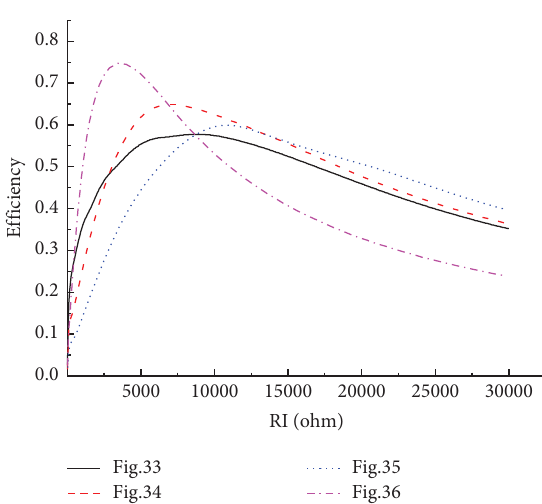
Fig.33 Fig.34 Figure 37: Te conversion efcient at various circuits